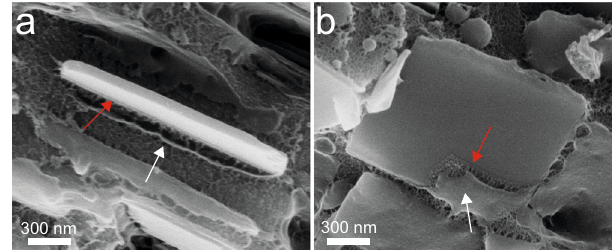
Fig. 3 | Cryo-SEM images of guanine crystals from an adult scallop eye. a Side view. b Top-down view of guanine crystals showing both the outer lipid vesicle membrane (white arrows) and an inner layer tightly bound to the crystal (red arrows). We assume the inner enveloping layer is the fi brillar sheets observed in juvenile scallop iridosomes which become fused to the crystal surface.